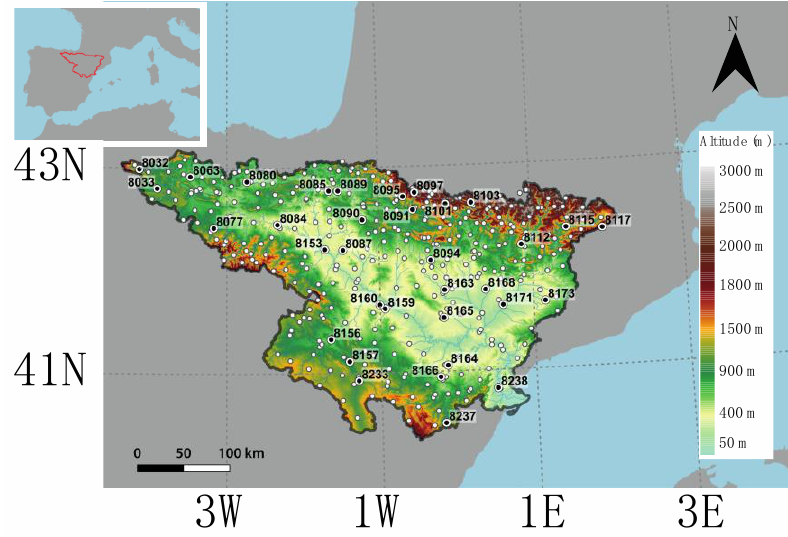
Figure 1. Topographic map of Ebro Basin including the spatial distribution of Automatic Hydrological Information System of the Ebro Hydrographic Confederation (SAIH-Ebro) rain gauge stations (white dots) and Spanish Meterological Agency (AEMET) stations (black dots).